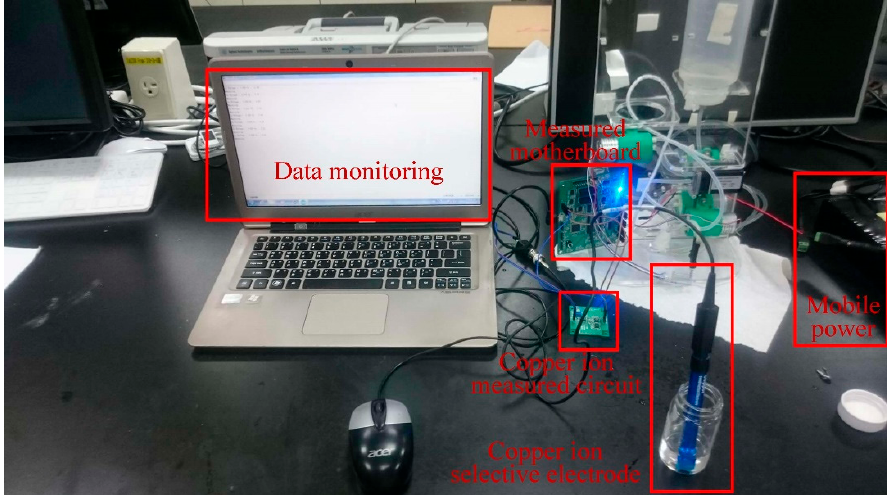
Figure 13. The experimental setup for measuring copper ion concentration.